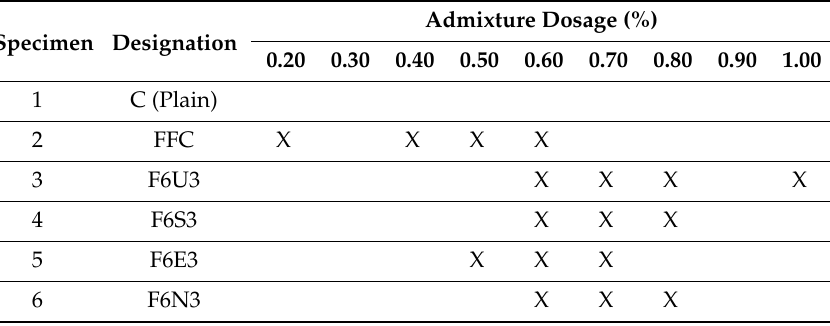
Table 3. Admixture tests on developed HyFRC (X: